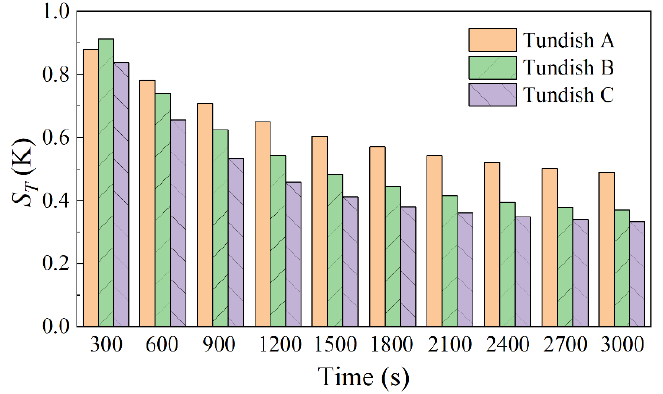
Figure 12. Standard deviation of molten steel temperature distribution in distributing chamber.